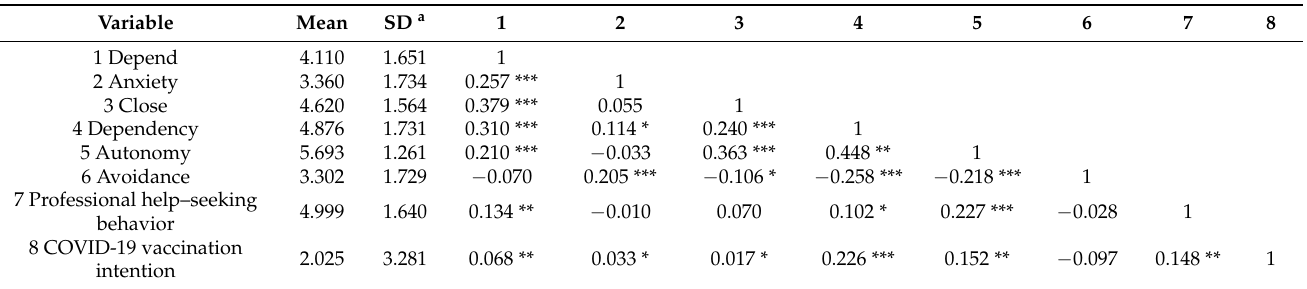
Table 1. Means, standard deviations, and correlations among variables for the measurement